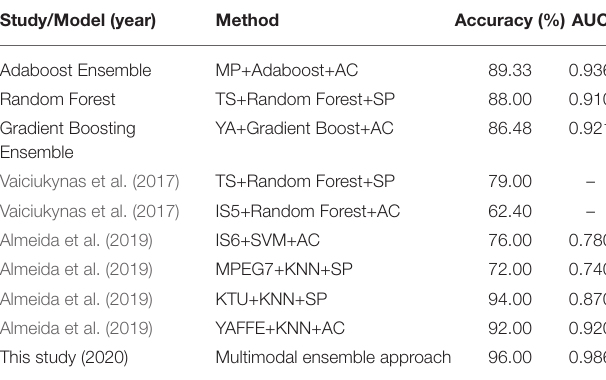
TABLE 13 | Comparative study with recently published